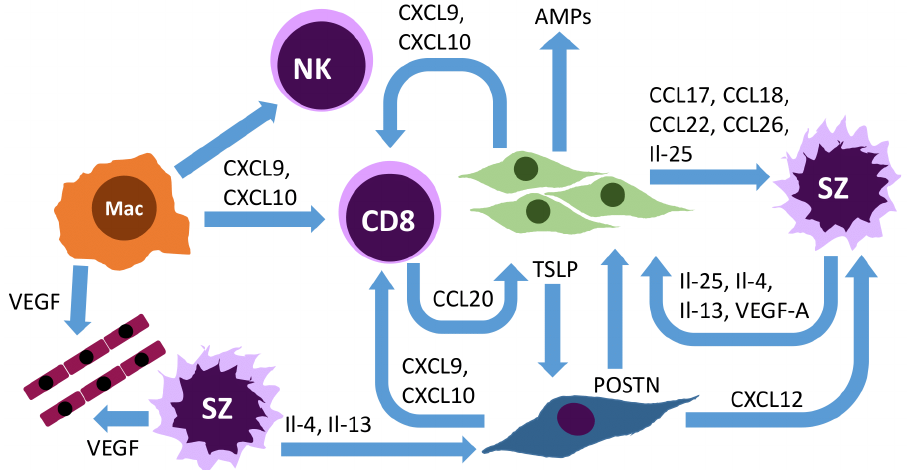
Figure 1. Interactions in the tumor microenvironment in mycosis fungoides and Sézary syndrome. The figure shows selected interactions in the microenvironment of mycosis fungoides. Cells in orange represent macrophages, green keratinocytes, blue fibroblasts, red endothelial cells, cells marked with SZ represent tumor cutaneous T-cell lymphoma cells (Sézary cells), CD8 cytotoxic lymphocytes, and NK natural killer cells. Abbreviations: AMP—antimicrobial peptide, CCL— chemokine ligand, CXCL-chemokine X ligand, Il—interleukin, POSTN—periostin, TSLP—thymic stromal lymphopoietin, VEGF—vascular endothelial growth factor.